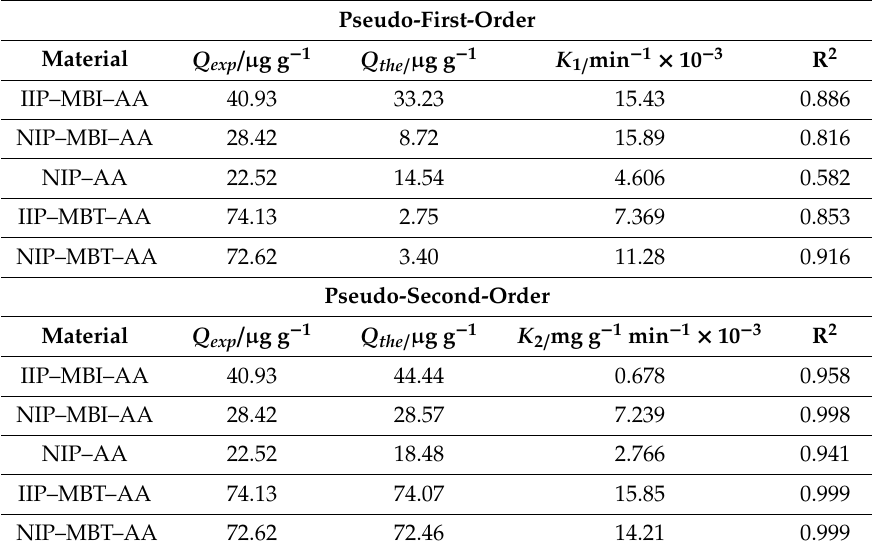
Table 4. Pseudo-first-order and pseudo-second-order adsorption rate